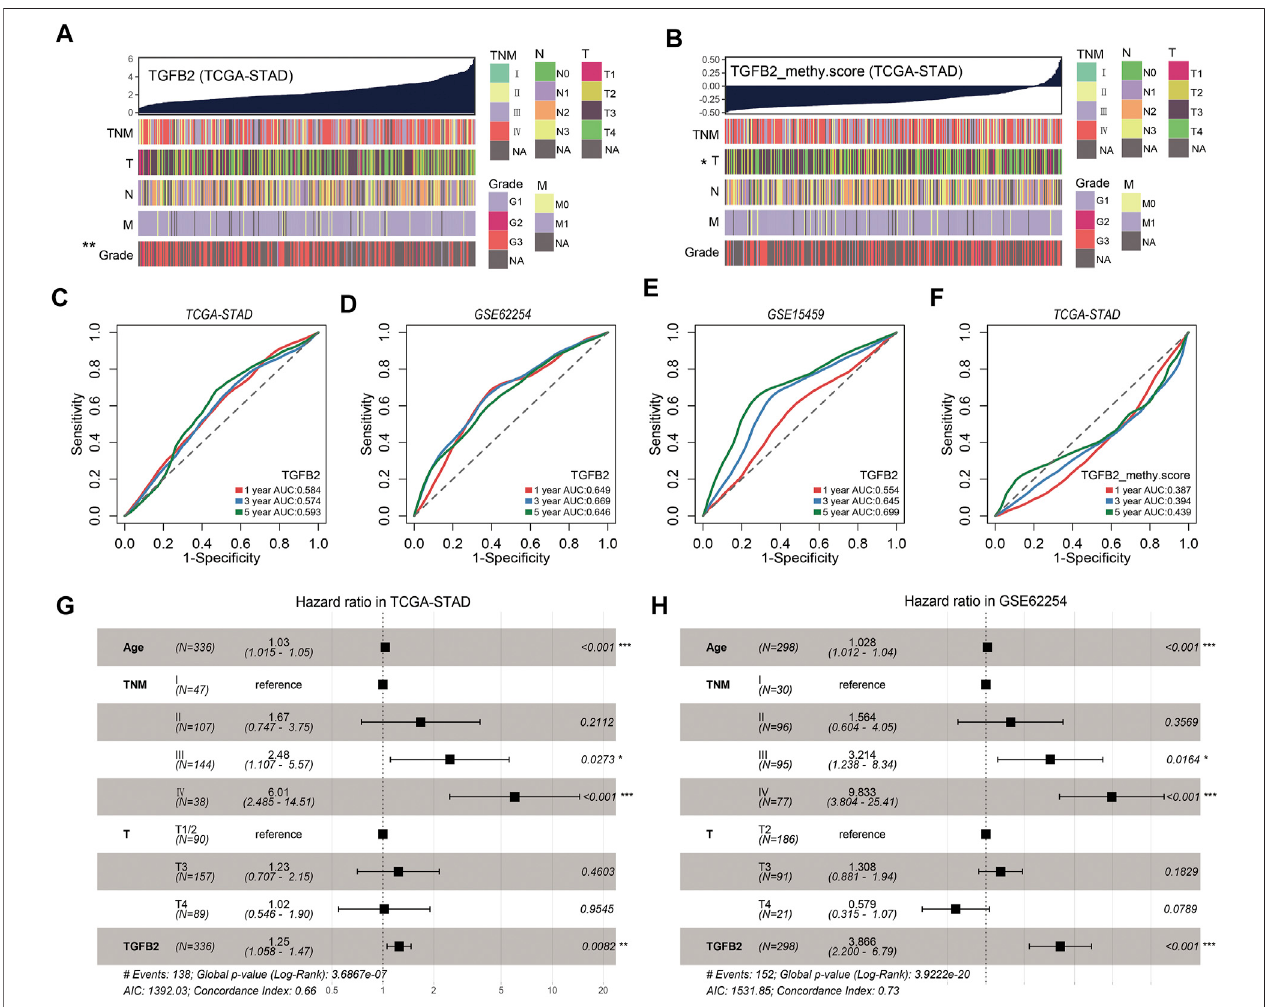
FIGURE9| TGF β 2andTGF β 2methylationscoresandclinicopathologicalfactors. (A) HeatmapofTGF β 2andclinicopathologicalfeaturesinSTAD. (B) Heatmapof TGF β 2 methylation score and clinicopathological features in STAD. The predictive value of TGF β 2 in patients in cohorts STAD (C) , GSE62254 (D) and GSE15459 (E) . The predictive value of TGF β 2 methylation scores in patients in cohorts STAD (F) . Multivariate Cox regression model analysis, which included the factors of age, TNM stage, T stage and TGF β 2 in the STAD (G) and GSE62254 (H) cohorts. * p < 0.05, ** p < 0.01, and *** p < 0.001.